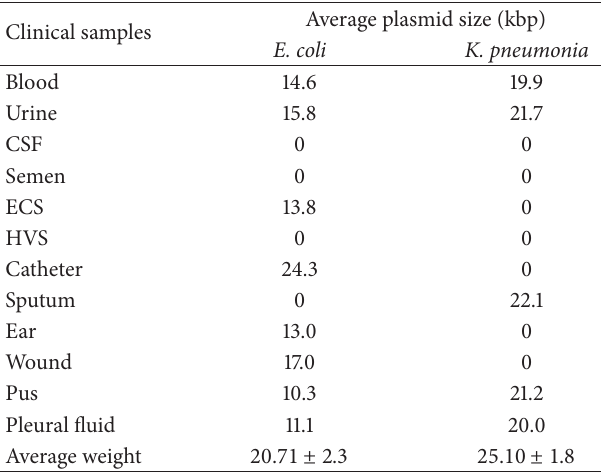
Table 4: R-plasmid profile of ESBL positive Escherichia coli and pneumonia among the clinical